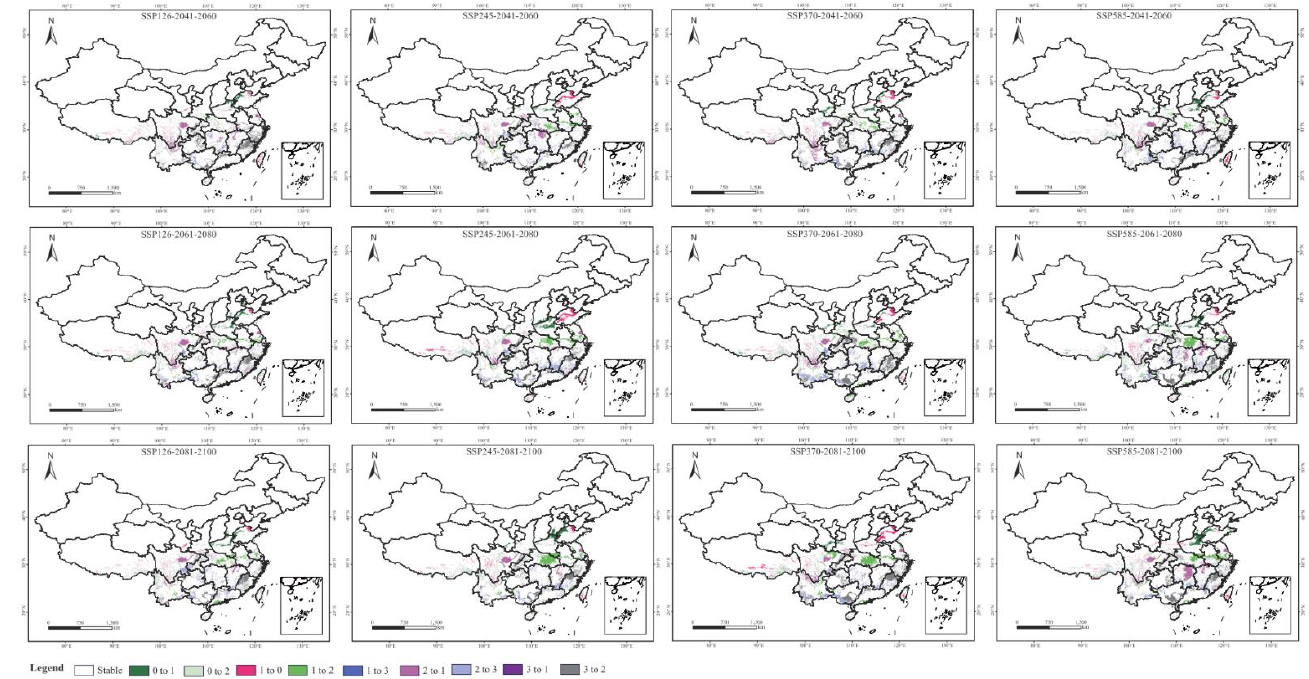
Figure 6. Changes in the current potential distribution to future distribution under SSP 126, 245, 370, and 585 from 2041 to 2100. “0” indicates Unsuitable habitat, “1” indicates Marginal suitable habitat, “2” indicates Medium suitable habitat, “3” indicates Optimal suitable habitat .